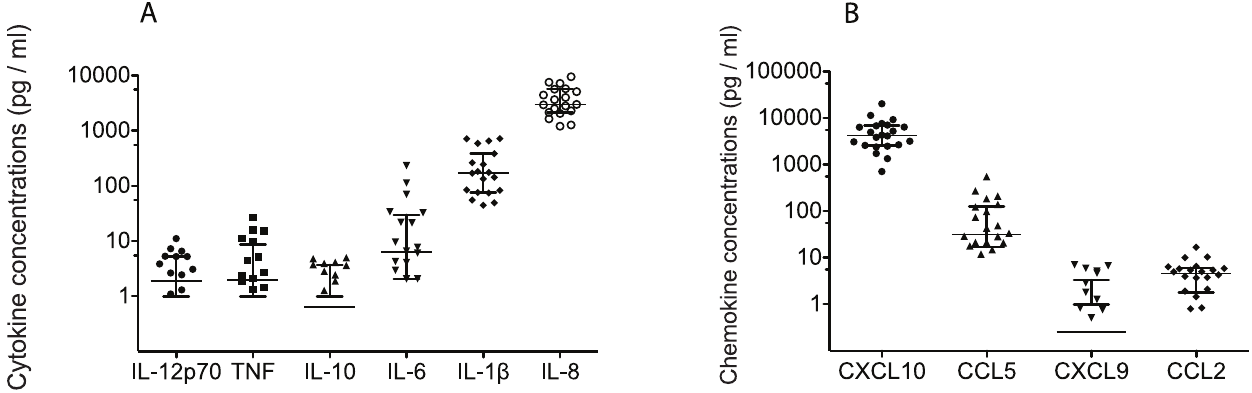
Figure 4. Concentration of A) cytokine and B) chemokine proteins measured in cervicovaginal secretions of RM. All samples were collected between menstrual cycle days 10–20 from 19–22 RM at Time point 2. Bars denote median and interquartile range. Note that if an assay produced a concentration of an analyte below the minimum quantifiable level, a value of zero was assigned and no data points for that sample appears in the